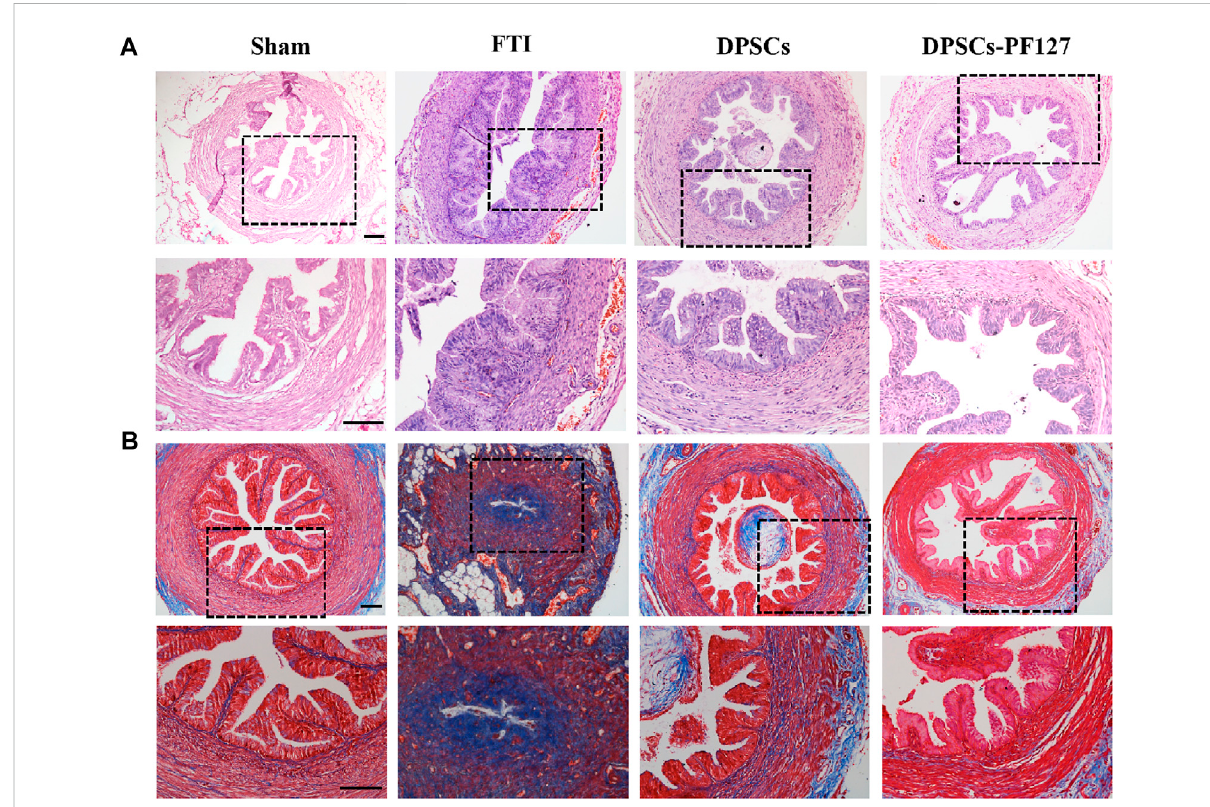
FIGURE 5 The H&E (A) and Masson trichrome (B) staining of FT after 4 weeks surgery among the groups. Scale bar: 100 μ m.